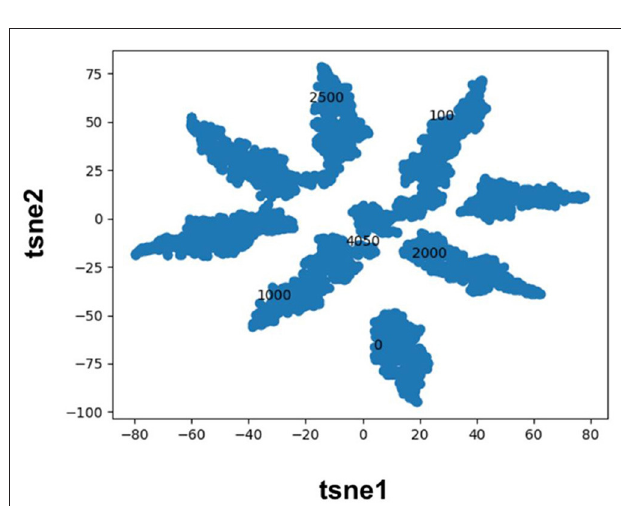
TABLE 3 | ChEMBL25 validation set performance metrics for both the RF and FFN models as well as the SMILES featurization method used. Model type MSE (scaled